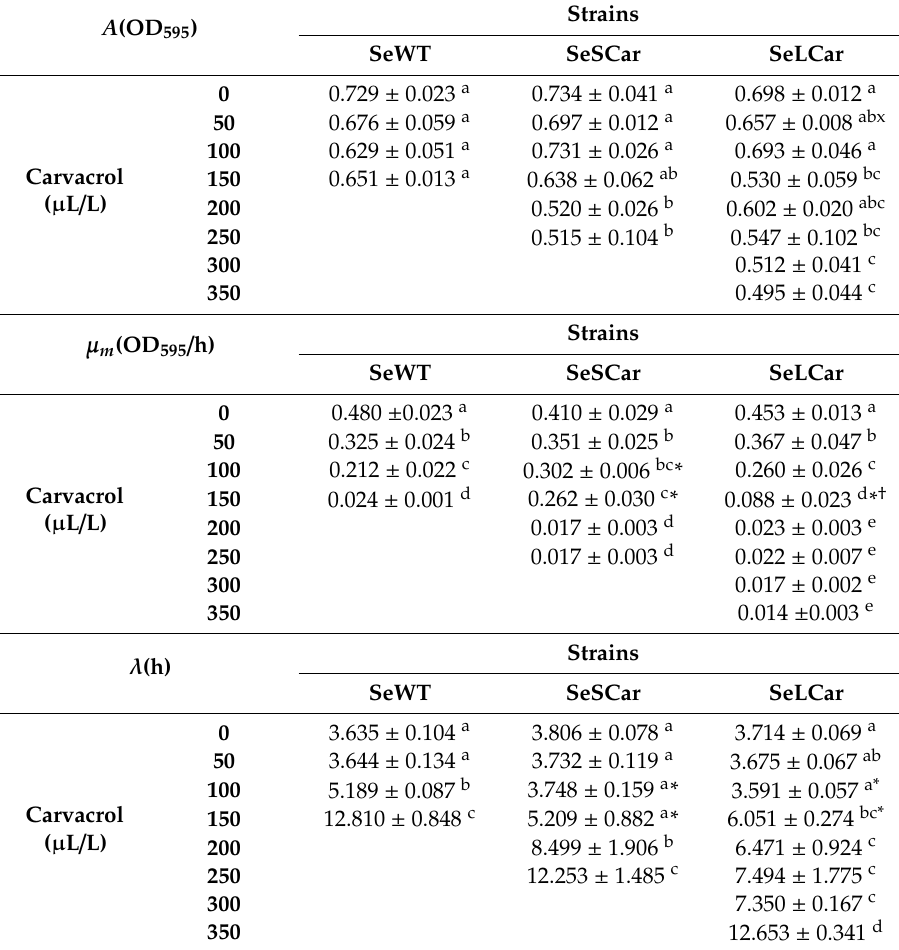
Each value represents the mean ± standard deviation from 3 independent experiments. Di ff erent superscript letters represent statistically significant di ff erences ( p ≤ 0.05) among the means of the same column. * Significantly di ff erent from SeWT ( p ≤ 0.05). † Significantly di ff erent from SeSCar ( p ≤